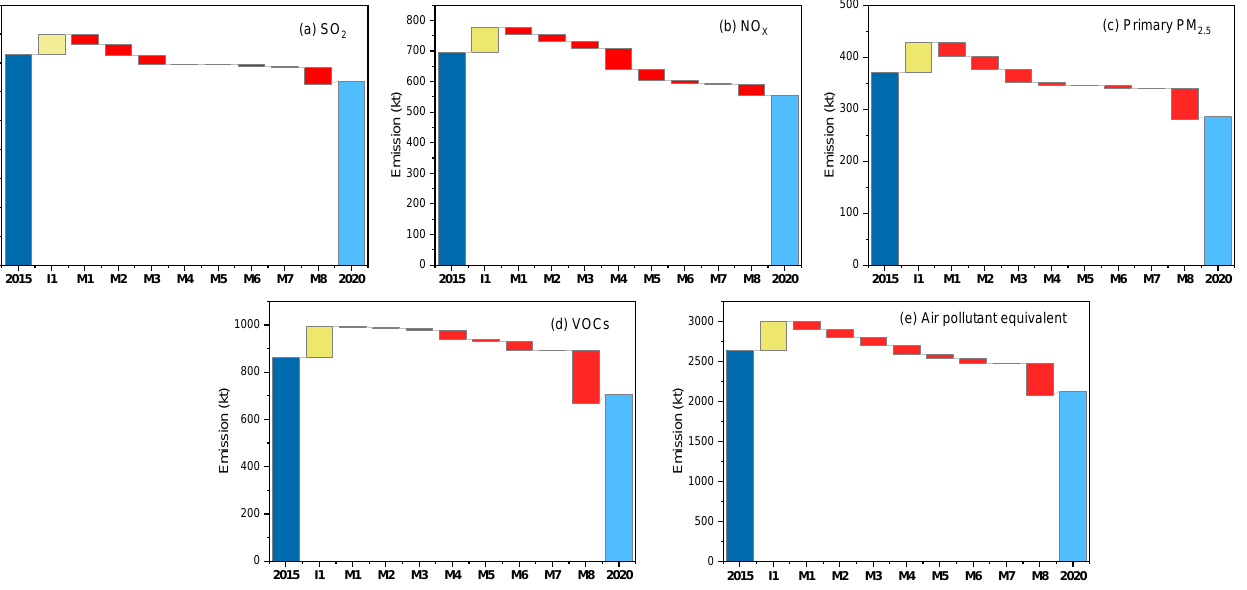
Figure 2. Changes in major air pollutant emissions in the GBA during the 13th Five-Year Plan period: ( a – e ) Emission changes in SO 2 , NOx, primary PM 2.5 , VOCs and in air pollutant equivalent.